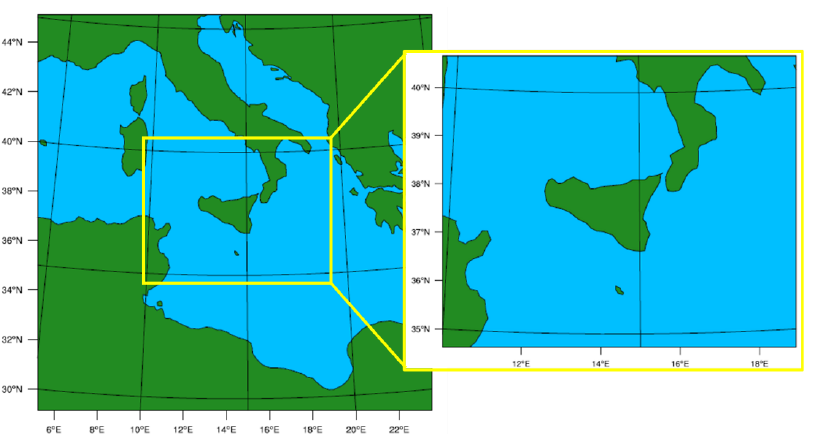
Figure 5. Map of the spatial domain used by the WRF model. The domain is centered in Sicily. The model is configured with a horizontal grid spacing of 5 km and a time interval resolution of 1 h.